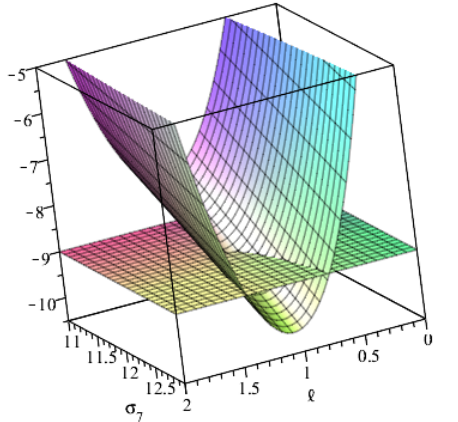
Figure 6 . A di(cid:11)erent view. Comparison between the lowest eigenvalue of R 2 bound, which is -9 in this case, as a function of ‘ and (cid:27) 7 , for (cid:28) 7 = 75. There are regions of stability for values of (cid:27) 3 below 12, which correspond to relatively large values for the ratio R 2 negative values of V 0